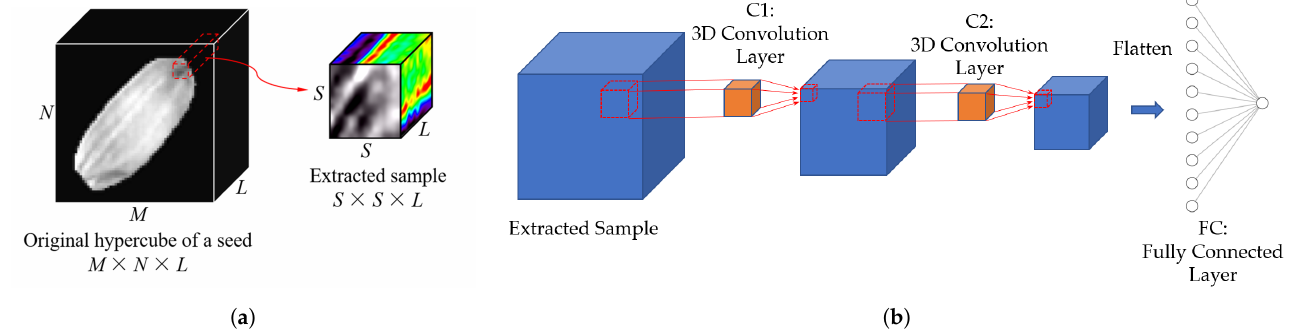
Figure 5. ( a ) Sample extraction and ( b ) network architecture of 3D